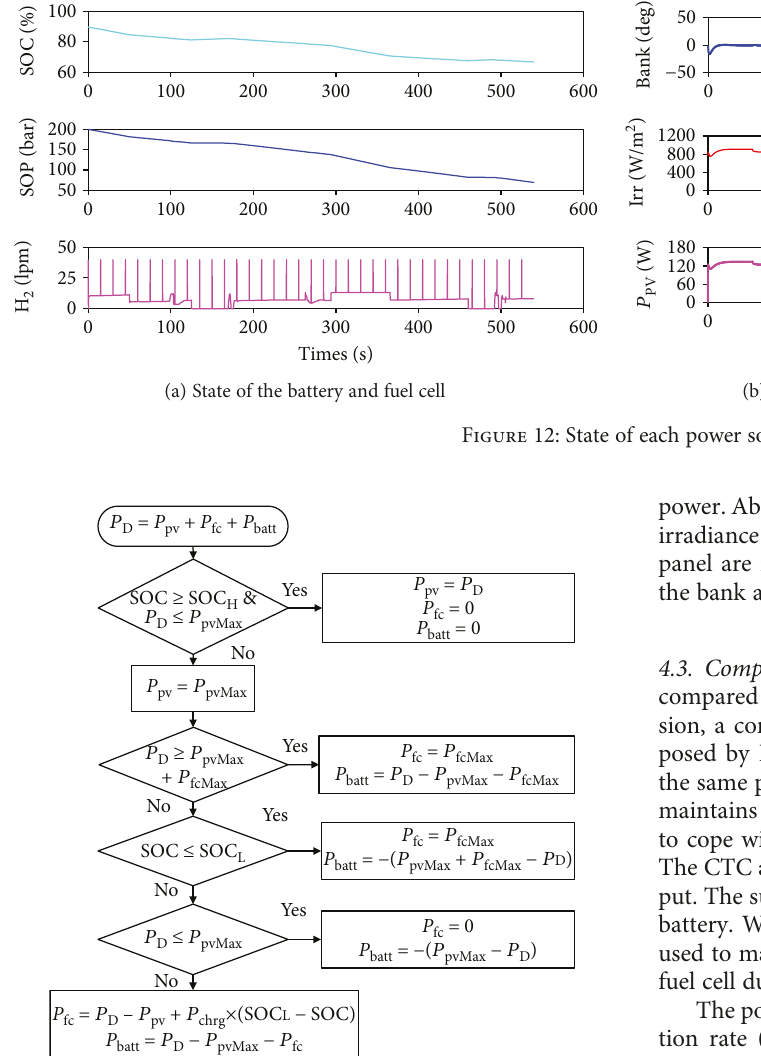
Figure 13: Diagram of the constrained thermostat control